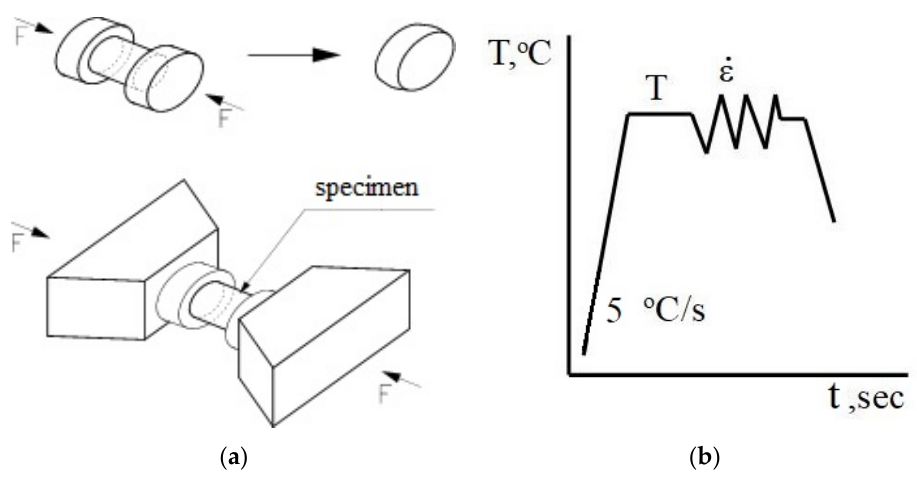
Figure 1. Geometry and dimension of load ( a ); and thermal cycle of physical simulation ( b ) [15]. The dependencies between stress and actual deformation (Figure 2a,c) for the AZ91 magnesium alloy was developed on the basis of plastometric tests. The obtained test results were approximated in order to determine the coefficients of Equation (1) (Table 2).